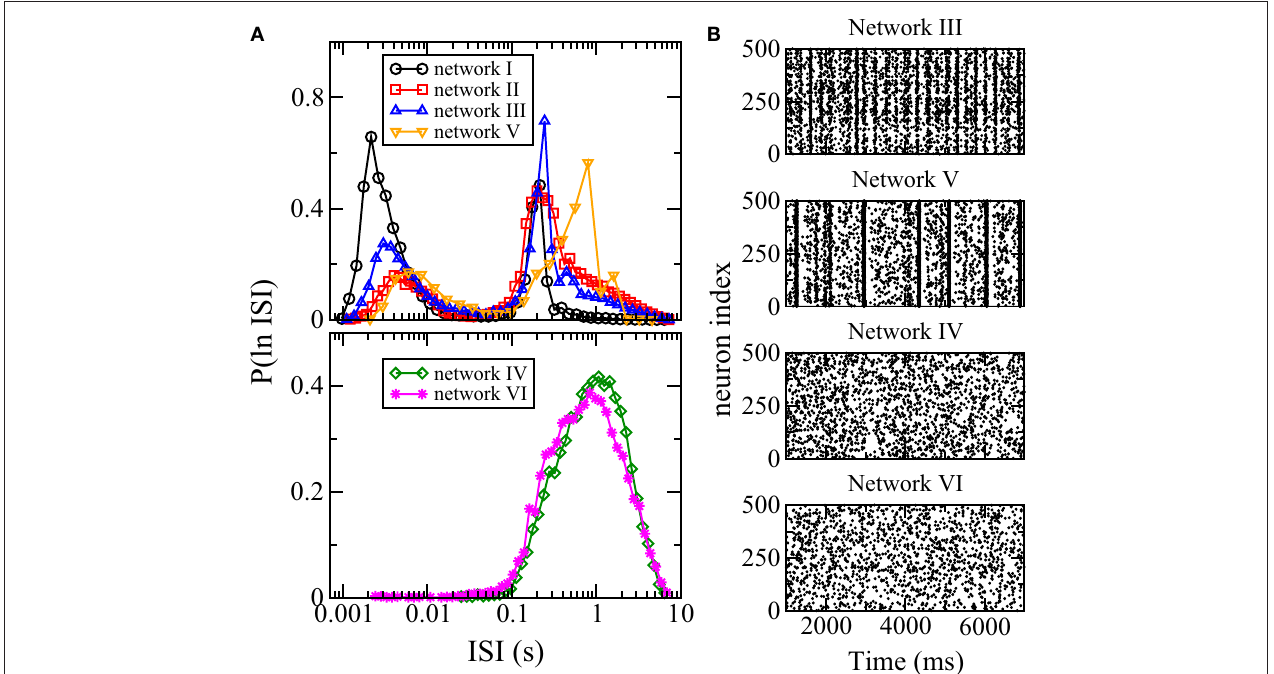
FIGURE 6 | Distribution of interspike intervals (ISI) and bursting. (A) Distribution P(ln ISI) for the six networks. (B) Raster plots of 500 randomly chosen neurons in networks III–VI. When distribution of ISI is bimodal, bursting is observed.